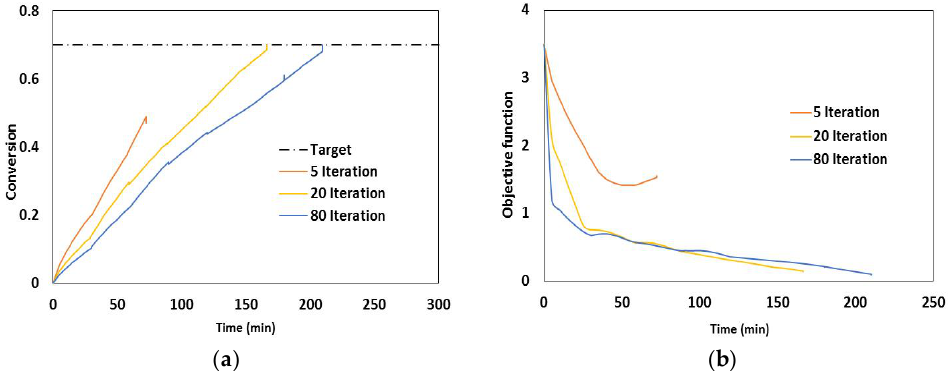
Figure 9. Conversion ( a ) and objective function ( b ) profiles at three different iterations.